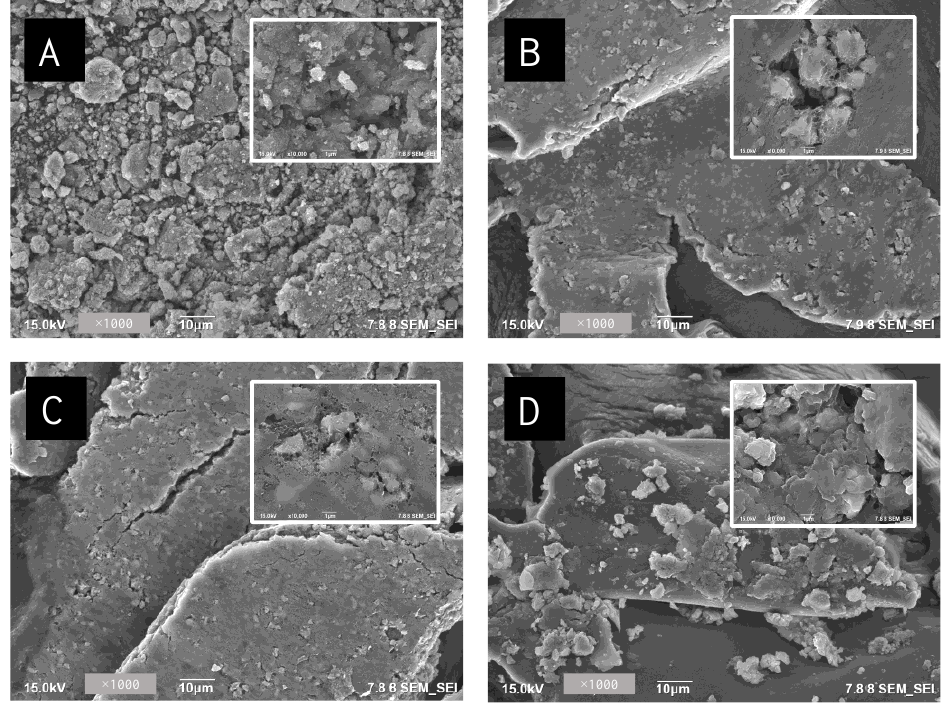
Figure 2. FE-SEM images of MRGO ( A ); Chi@MRGO ( B ); PF127-Chi@MRGO ( C ); α -mangosteen -loaded PF127-Chi@MRGO nanocomposites ( D ).